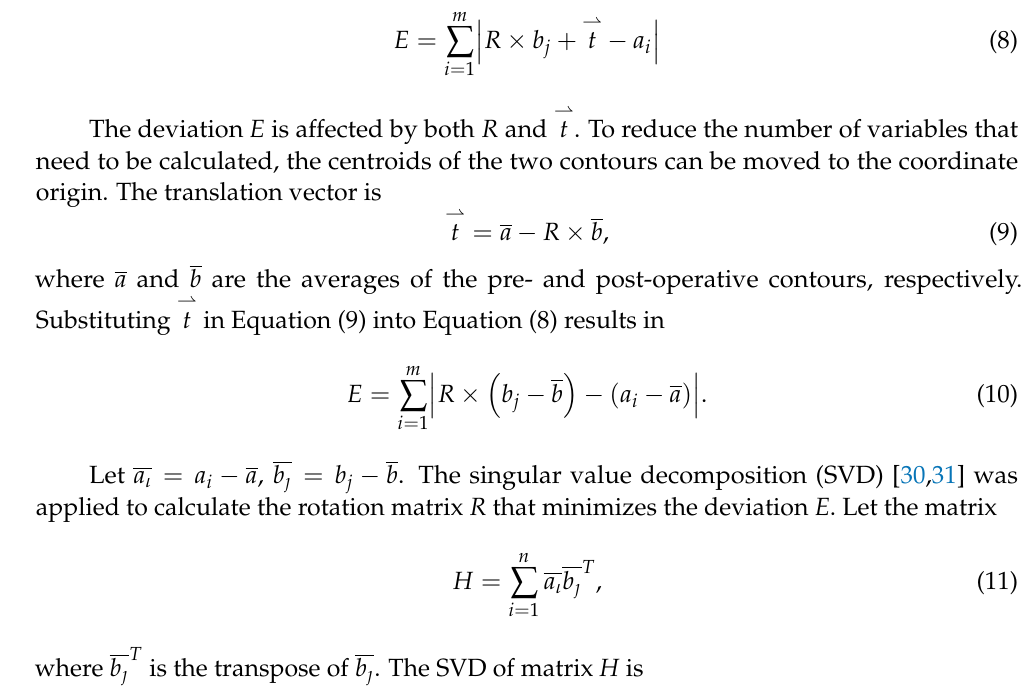
The K-D tree provided the nearest point searching. A rotation matrix R and a trans- lation vector 𝑡⃑ exist such that the post-operative contour 𝑏 (cid:3037) would transform to its matching pre-operative contour 𝑎 (cid:3036) , or in other words, 𝑎 (cid:3036) = 𝑅 × 𝑏 (cid:3037) + 𝑡 ⃑ . However, the two superimposed contours are not exactly the same, which will cause deviations, expressed as follows: